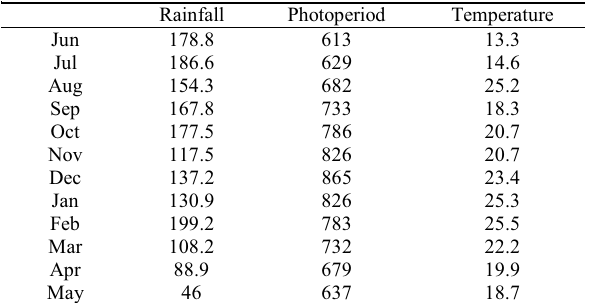
Table 5. Monthly variation of the rainfall (mm), water tem- perature (°C) and photoperiod values in Lagoa Negra. Rainfall Photoperiod